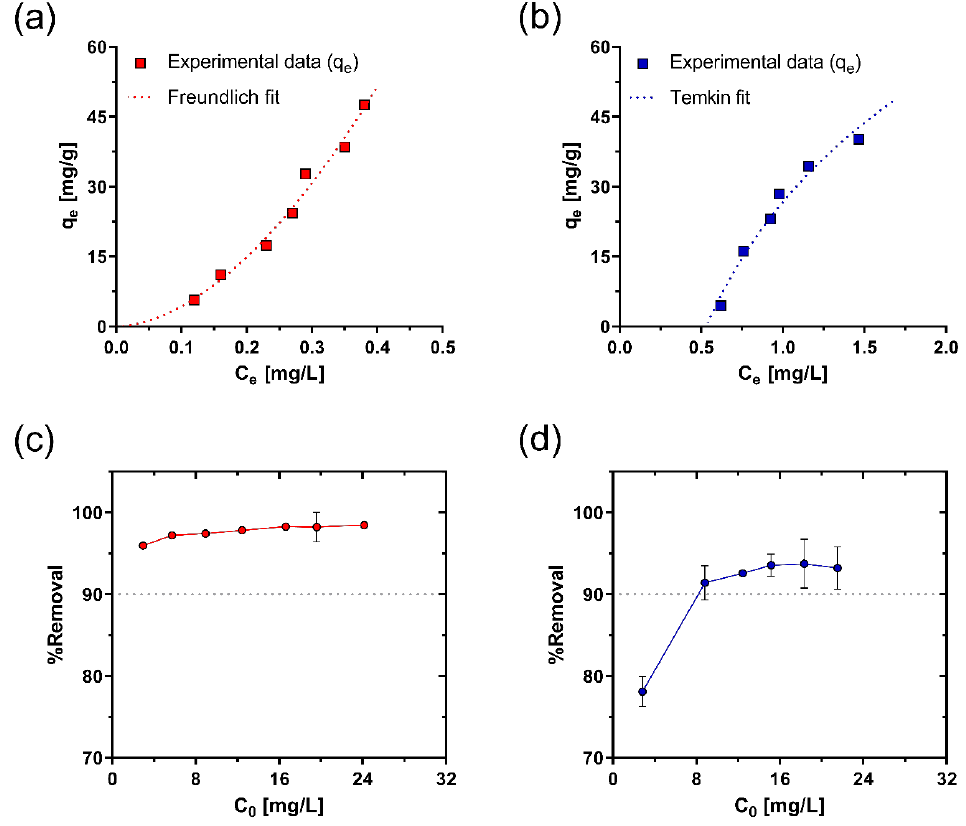
Figure 5. Adsorption isotherms for Cu(II) under ( a ) pH1 (pH = 4.8) with Freundlich isotherm model fit, and ( b ) pH2 (pH = 4.0) with Temkin isotherm model fit using ZnO NPs as nanoadsorbent. Removal percentages for Cu(II) under ( c ) pH1 (pH = 4.8) and ( d ) pH2 (pH = 4.0).